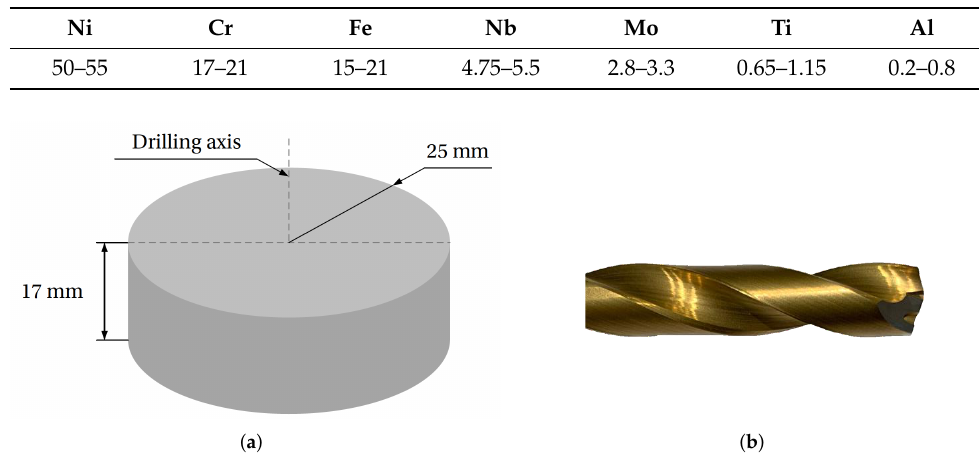
Table 1. Chemical composition of Inconel 718 superalloy (in wt%).